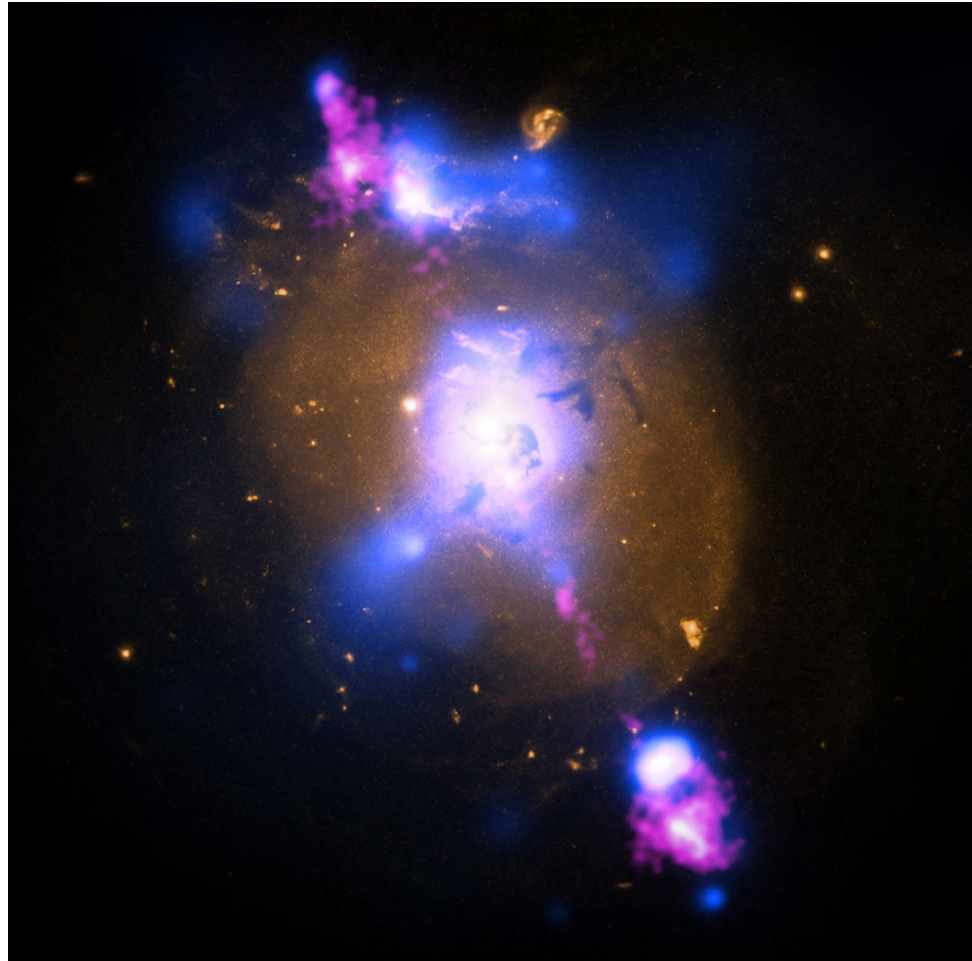
Figure 1. Composite image of radio-loud AGN 4C+29.30, with Chandra X-ray, HST optical and VLA radio observations [47,48]. Three different time periods of radio activity have been detected studying the radio-jet emission in this galaxy, which can be related with the galaxy interaction history (with clear signatures observed in the optical) and the feeding of the central SMBH. Credit: X-ray: NASA/CXC/SAO/A.Siemiginowska et al; Optical: NASA/STScI; Radio: